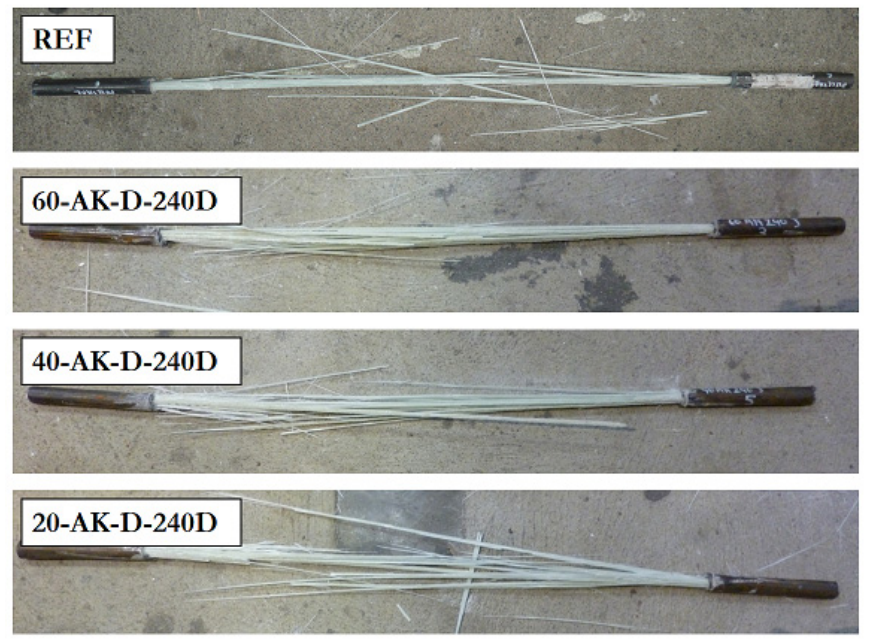
Figure 12. Typical failure modes after tensile tests on aged GFRP rebars and reference samples.